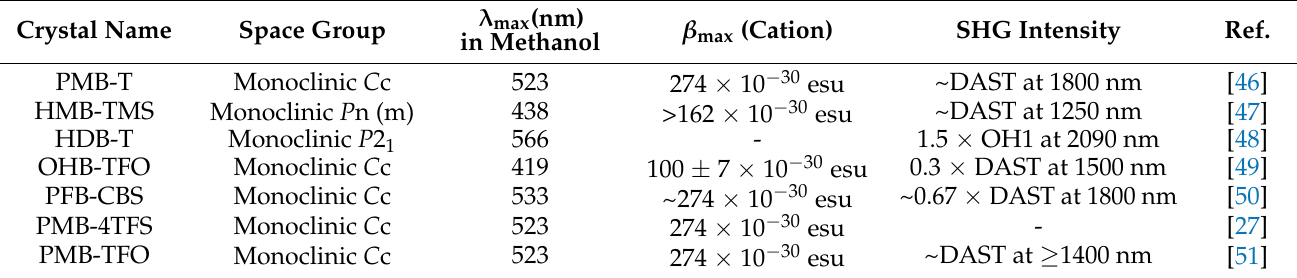
Table 3. Comparison of the mentioned benzothiazolium-based THz crystals.